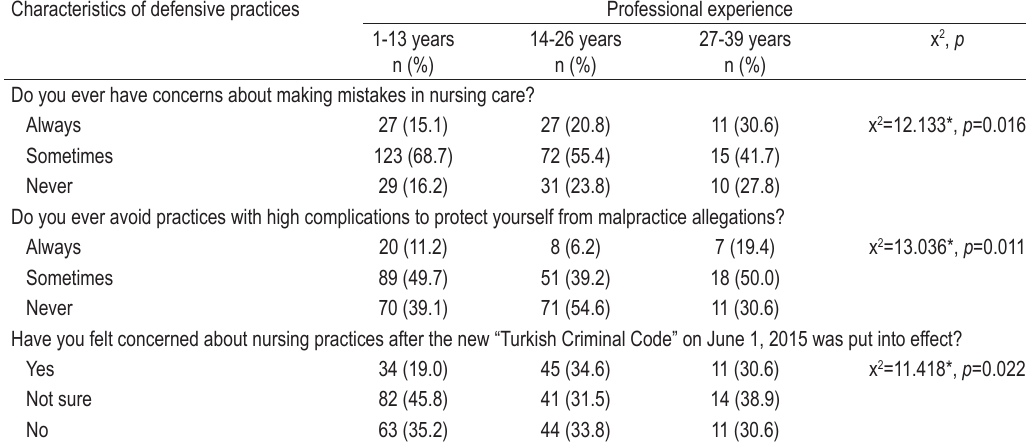
TABLE 5. Nurses’ characteristics of defensive practice in regard to their period of professional experience (n=345) Characteristics of defensive